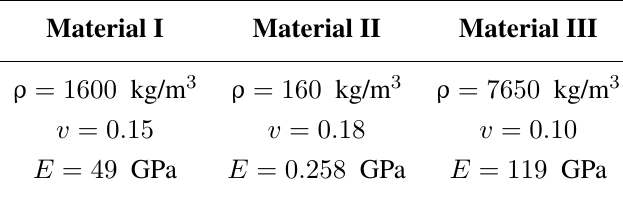
Table 1. Mechanical properties of materials.